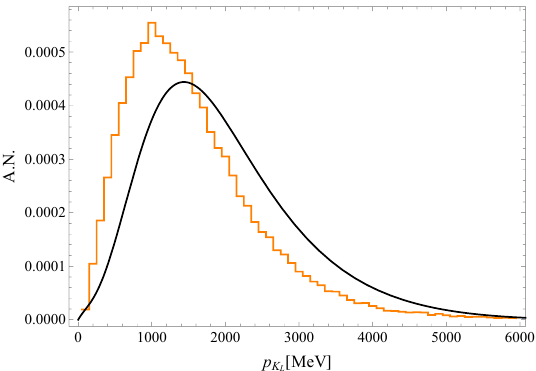
Figure 2 . Left: the solid black line represents the measured K L momentum distribution in a special run at the beam exit ((cid:12)gure 6 of [65]). The histogram shows the momentum distribution of K L decaying within the detector (the normalization is